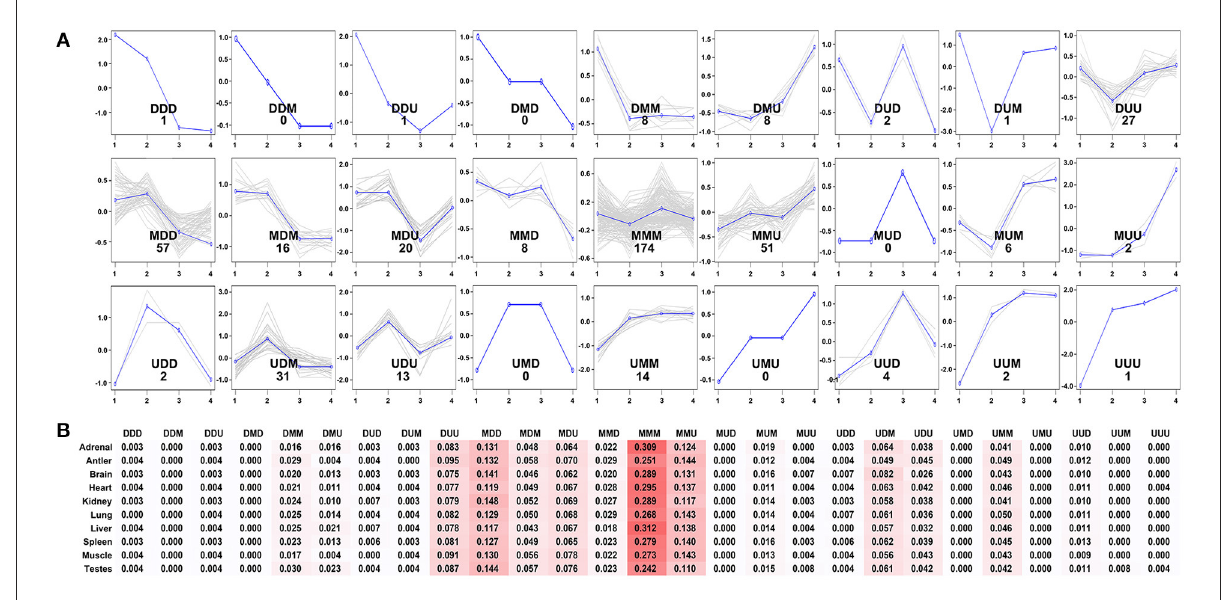
FIGURE6 Expression patterns of the development-dependent miRNAs of the Sika Deer. (A) The 27 expression patterns of the DE miRNAs obtained by ANOVA between any two sequential stages of development. (B) The percentages of miRNAs expression patterns in each tissue.